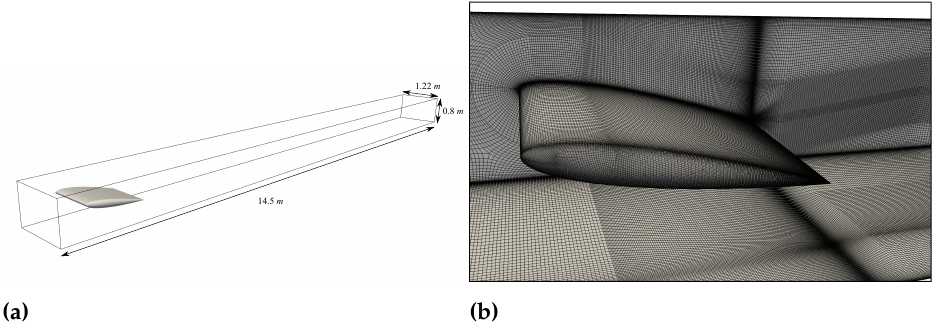
Figure 20. (a) Domain (wind tunnel) encapsulating the NACA0012 finite wing. (b) Sample mesh of Figure 20. ( a ) Domain (wind tunnel) encapsulating the NACA0012 finite wing. ( b ) Sample mesh of the NACA0012 wing case the NACA0012 wing case.